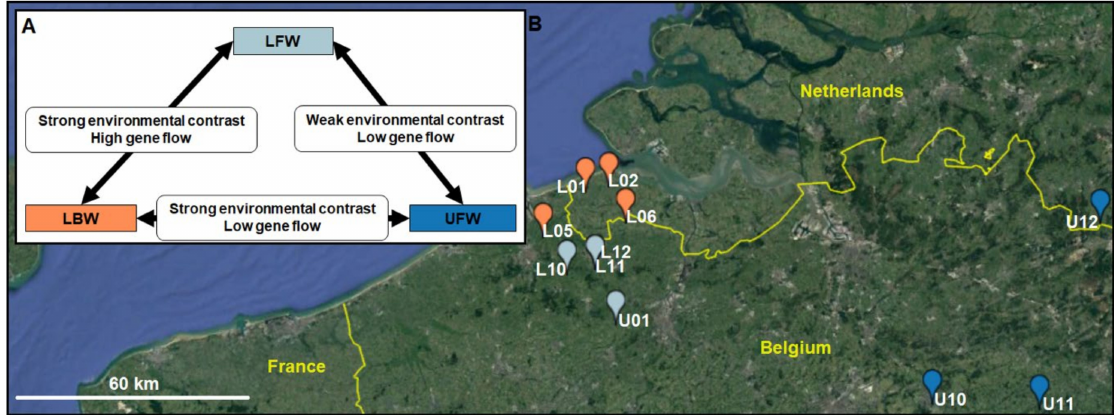
Figure 1. ( A ) Triangle representing the contrast among the three geographical scales. ( B ) Overview of the study area, lowland brackish water (LBW), lowland freshwater (LFW), and upland freshwater (UFW) are represented by orange-red, light-blue and dark-blue dots,